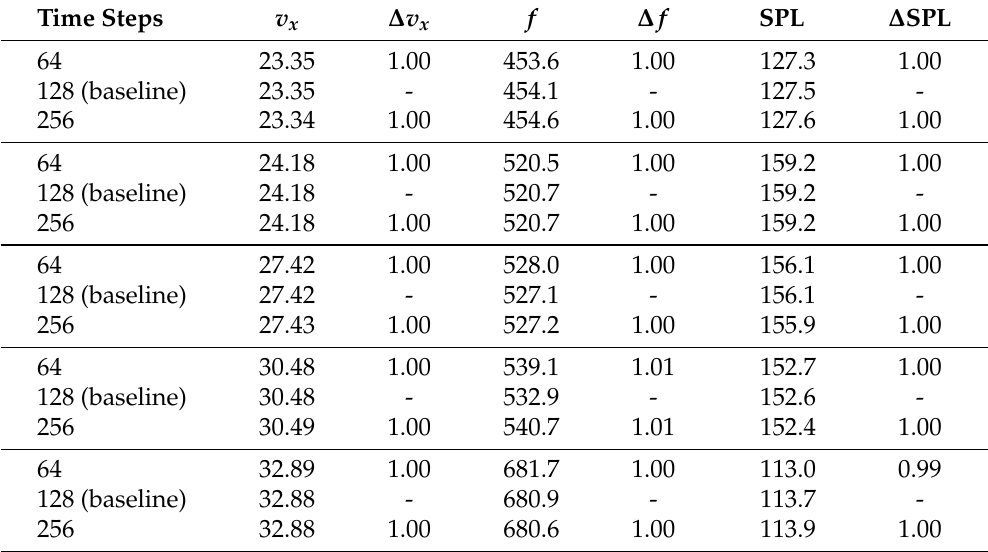
Table 4. Influence of physical time step on velocity, shedding frequency, and sound pressure